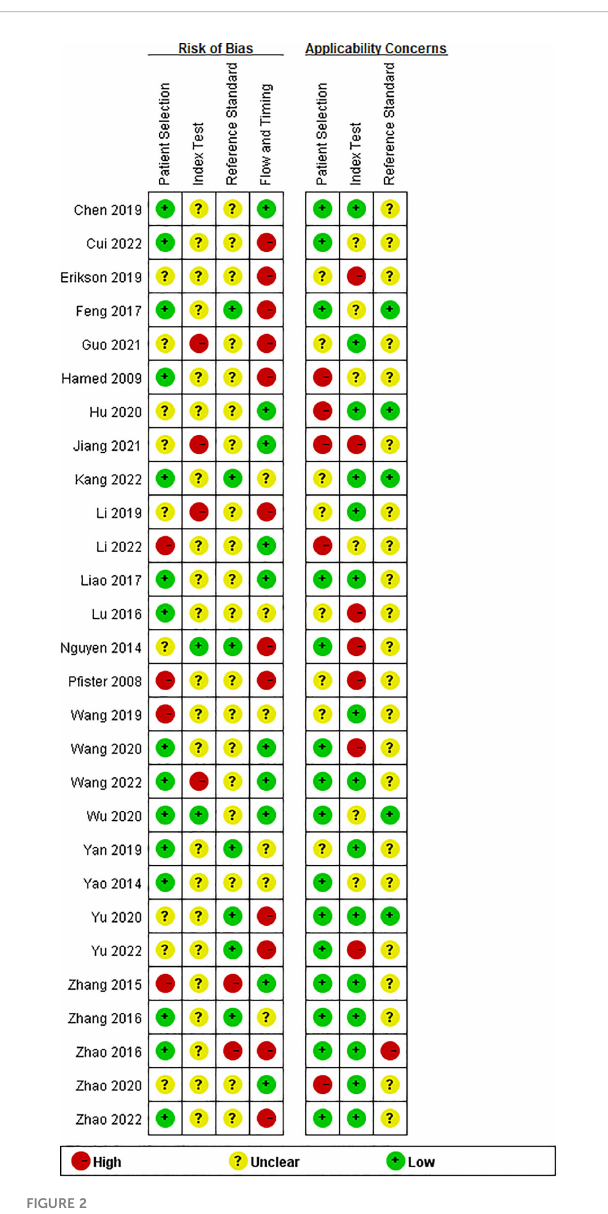
FIGURE 2 Risk of bias and applicability concerns summary: review authors ’ judgements about each domain for each included study.